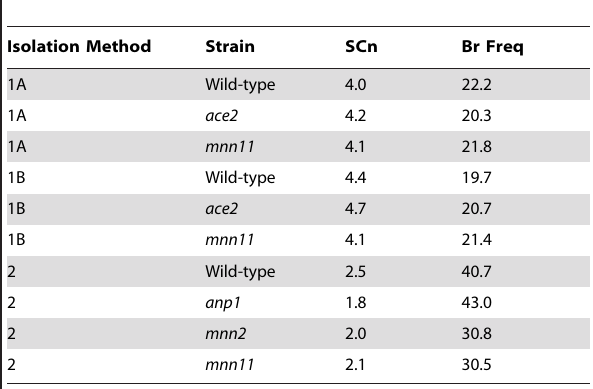
Table 2. Comparison of average side chain lengths, SCn, and branching frequencies, Br Freq, for several strains of C. glabrata isolated by 2 different